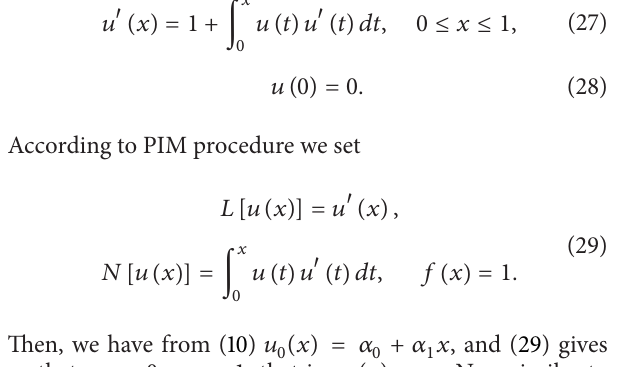
Figure 1: The valid region of ℎ . Example 1 shows −1.2 ≤ ℎ ≤ −0.8 .